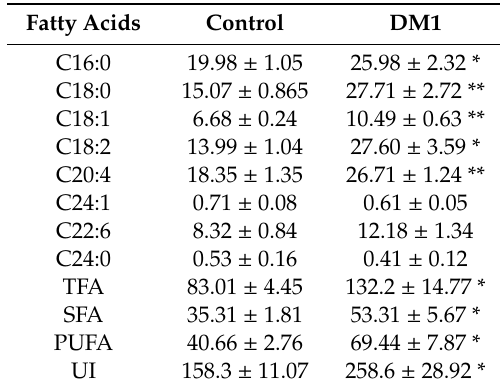
Figure 6. Fluidity of liver mitochondrial membranes of control and diabetic rats. The composition of the incubation medium was as indicated in Figure 5. Values are given means ± SEM ( n = 5). *** p < 0.001 compared to controls. Table 2. DM-related changes in the fatty acid composition of the mitochondrial membrane ( µ g per mg of mitochondrial protein).